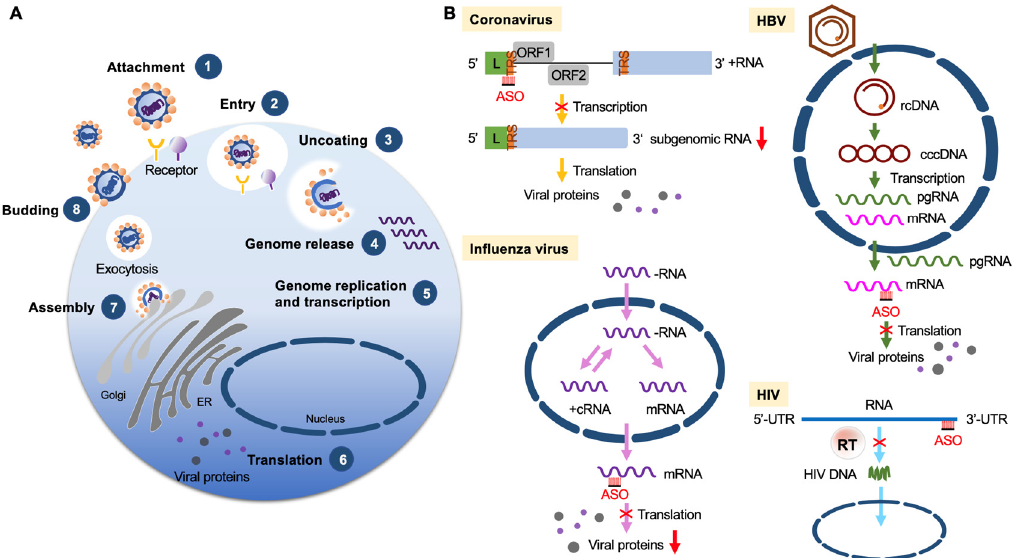
Figure 3. ASOs targeting viruses. ( A ) Diagram shows viral life cycle from viral attachment and entry into host cells (1, 2), genome release from the capsid (3, 4), genome replication, transcription and protein expression (5, 6), and viral assembly and release (7, 8). ( B ) ASO-based antiviral strategies. Examples are given for four different types of viruses. Coronavirus (positive-strand RNA virus): ASOs target the transcription regulatory sequence (TRS) of the RNA genome (+RNA) to reduce viral subgenomic RNA production. Influenza (negative-strand RNA virus): ASOs target viral mRNAs to reduce the production of viral nucleoprotein and matrix protein. HBV (partially double-stranded DNA virus): ASOs target a conserved sequence of viral mRNAs to reduce the translation of viral proteins. HIV (retrovirus): ASOs bind to the viral genome to interfere with reverse transcription and hence reduce viral DNA production. Abbreviations: L, leader sequence; cRNA, complementary RNA; rcDNA, relaxed circular DNA; cccDNA, covalently closed circular DNA; pgRNA, pregenomic RNA.